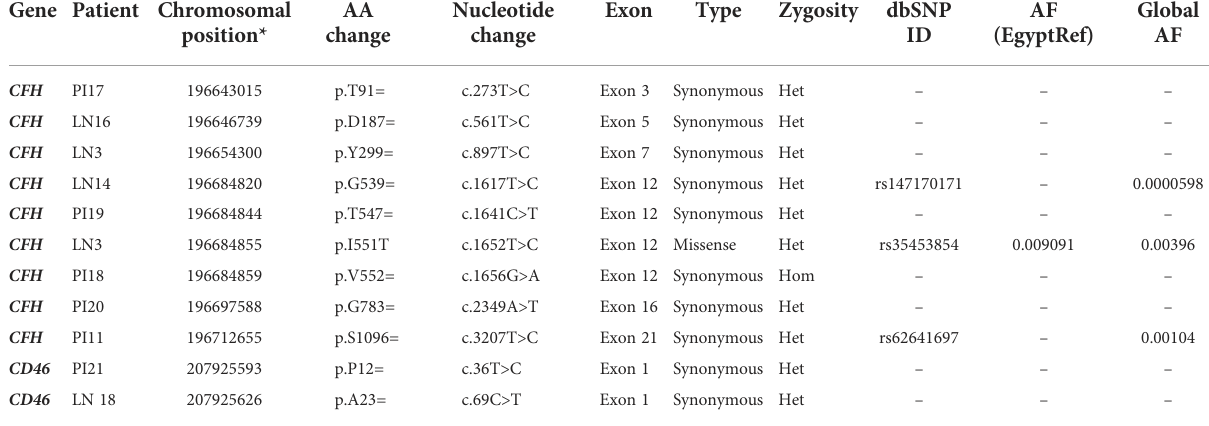
TABLE 3 Benign/Likely benign